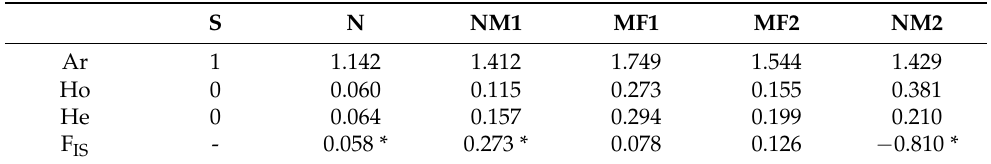
Table 2. Chromosome variability parameters in six populations of L. monticola (S: Southern; N: Northern; NM1: Northern Modified 1; MF1: Multiple Fissions 1; MF2: Multiple Fissions 2; NM2: Northern Modified 2). Allele richness (Ar), observed (Ho) and expected (He) heterozygosity, and inbreeding coefficient (F IS ), * p < 0.05.